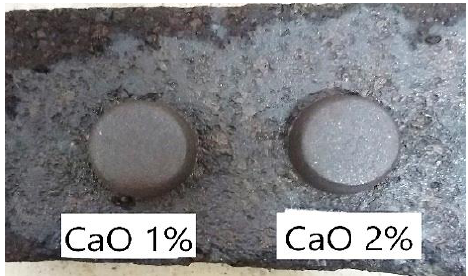
Figure 5. Peridotite sample E6382 with the Al 2 O 3 addition after calcination. Figure 6. Peridotite sample E6382 with the SiO 2 addition after calcination. Figure 7. Peridotite sample E6382 with the MgO addition after calcination.